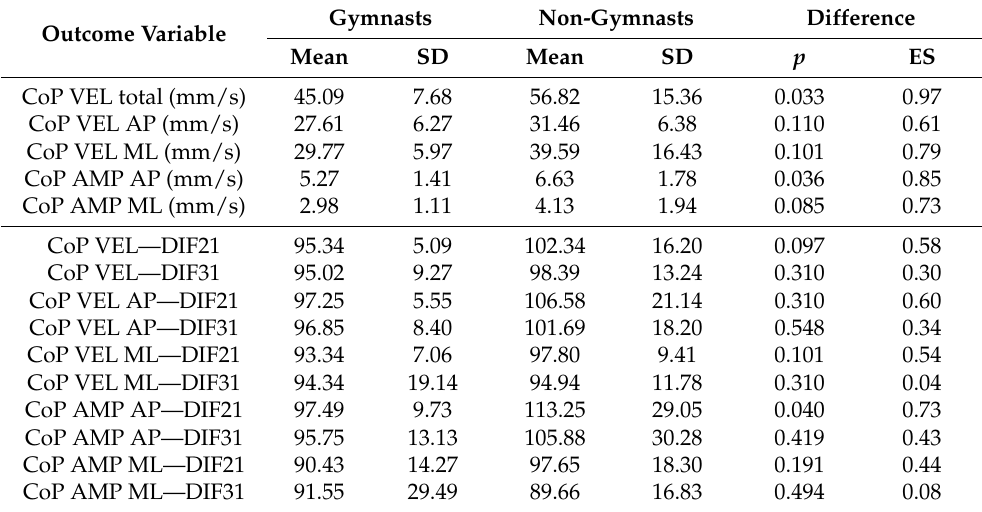
Table 2. The comparison between gymnasts ( n = 15) and non-gymnast groups ( n = 15). Gymnasts Non-Gymnasts Difference Outcome Variable Mean SD